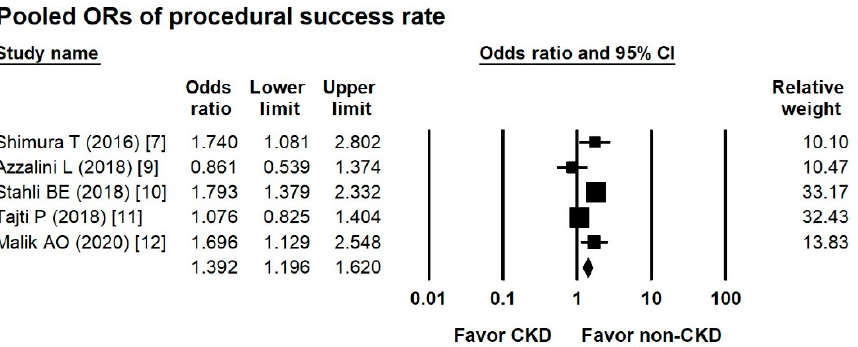
Figure 3. Forest plots of the procedural success rate between the CKD and non-CKD groups from six studies.